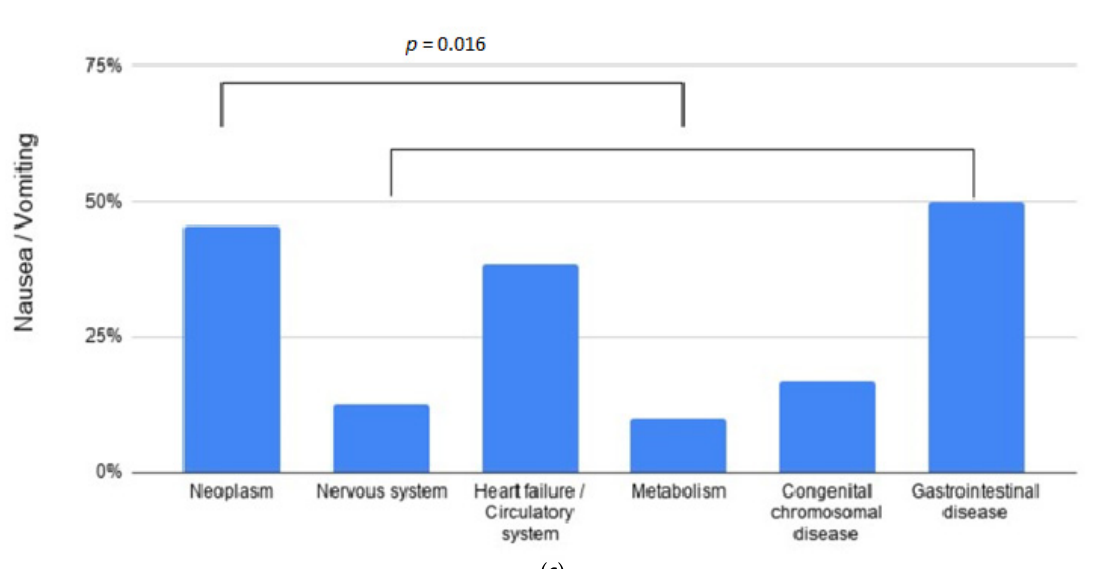
Figure 1. Frequency of symptoms (%) related to the underlying disorder. Figure legend: The first (lower) bracket comprises the group of non-oncological diseases (columns 2–6). These five diseases were compared to the neoplasm group (column 1). The second (upper) bracket indicates the significance of the difference regarding a given symptom (shortness of breath, pain, nausea/vomiting) between patients with oncological and non-oncological diseases. ( a ) Frequency of shortness of breath (%) related to the underlying disorder. We found no significant differences between oncological and non-oncological conditions. ( b ) Frequency of pain (%) related to the underlying disorder. A significant higher number of oncological patients suffered from pain compared to other conditions. ( c ) Frequency of nausea/vomiting (%) related to the underlying disorder. A significantly higher number of oncological patients suffered from nausea/vomiting compared to other conditions. Of all the metabolically ill patients, 70% ( n = 7) experienced fear and restlessness at the end of their life. Cardiological patients suffered mostly from dyspnea (84.6%, n = 11), which can be explained primarily by cardiac decompensation and pulmonary edema. Of all the metabolically ill patients, 80% ( n = 8) complained of shortness of breath in the ter- minal phase. Pain occurred significantly more frequently in oncological patients ( p = <0.01), in total in 86% ( n = 36) (see Figure 1a). A total of six oncological patients (14% of all oncological patients) had mild/no pain symptoms during basic treatment with dexame- thasone and infrequent non-opioid analgesics at the end of their life. All six children suf- fered from a brain tumor. Of the oncological patients, 45% ( n = 19) complained of nau- sea/vomiting, partly due to therapy, partly because of increased intracranial pressure in the context of a brain tumor. Oncological patients vomited significantly more often than non-oncological patients ( p = 0.016) but vomiting also occurred in 38% ( n = 5) of all cardiac patients. Of the metabolically ill patients, 60% of ( n = 6) complained of constipation, as well as 47% ( n = 20) of all oncological patients and 43% ( n = 7) of all neurological patients.